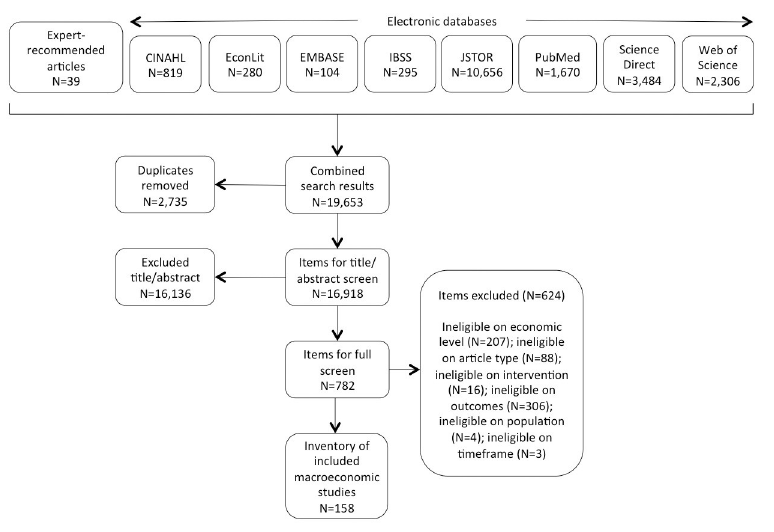
Fig 1. Screening